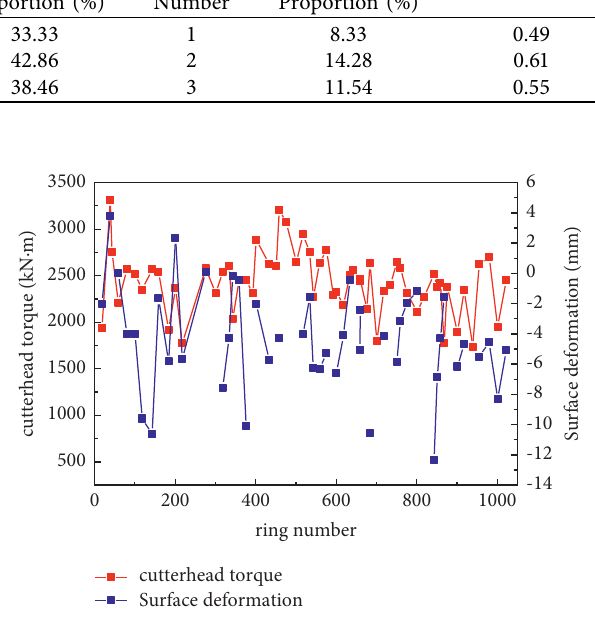
Figure 13: Relationship between displacement and torque of the latter